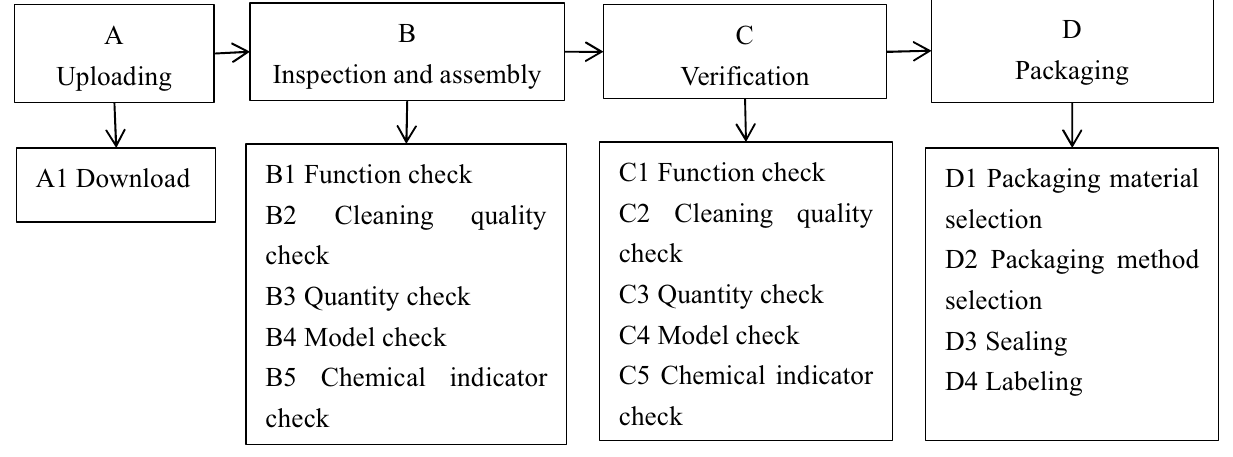
Figure 1. Exploded diagram of the packaging